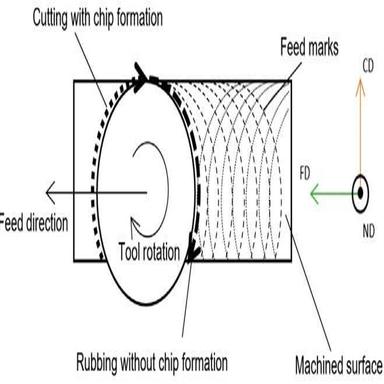
Schematic indicating the key regions of the tool rotation responsible for the difference in shear textures.